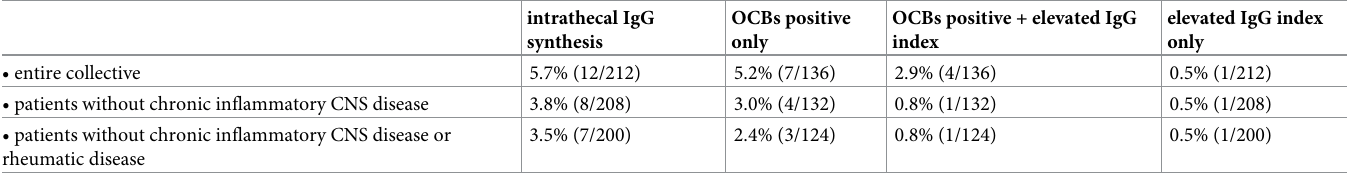
Table 3. Occurrence of intrathecal IgG synthesis in context of autoimmune